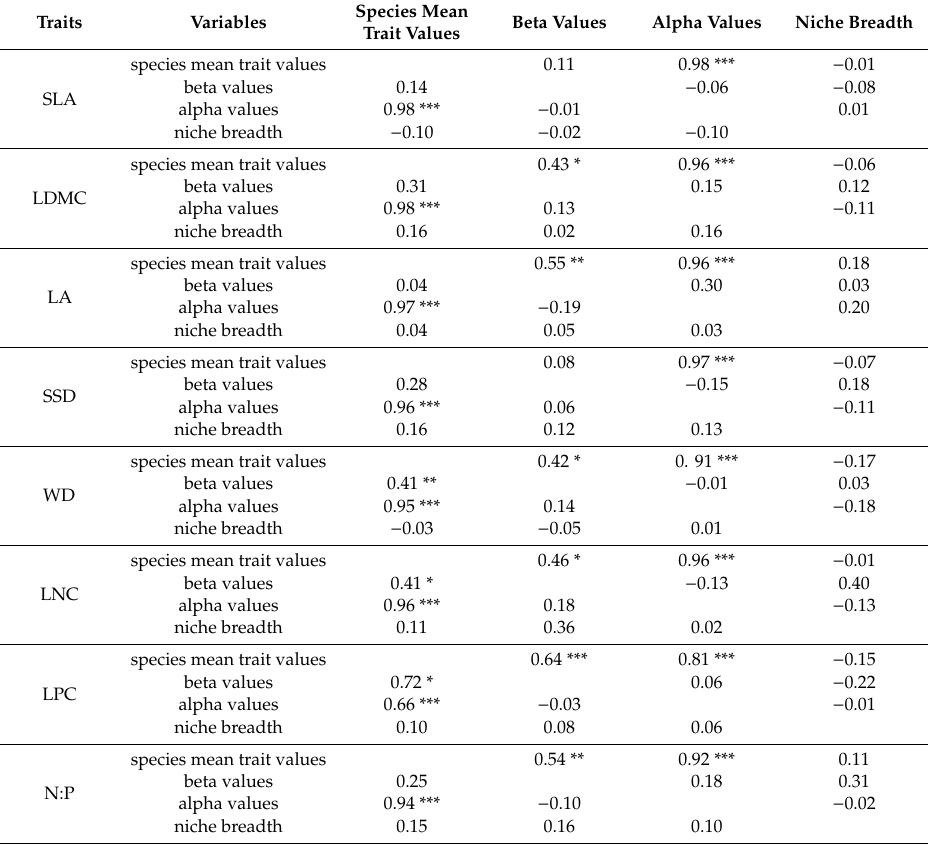
Table 2. Pairwise correlation coe ffi cients between evergreen and deciduous species for mean trait values, beta values, alpha values, and niche breadth for the seven functional traits measured in a subtropical evergreen deciduous broadleaved mixed forest in Central China. * p < 0.05; ** p < 0.01; *** p <